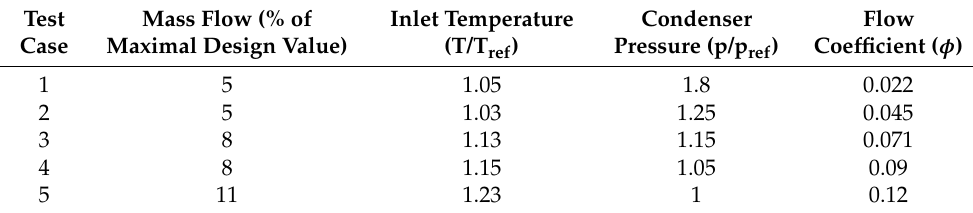
Table 3. Summary of some representative test cases.